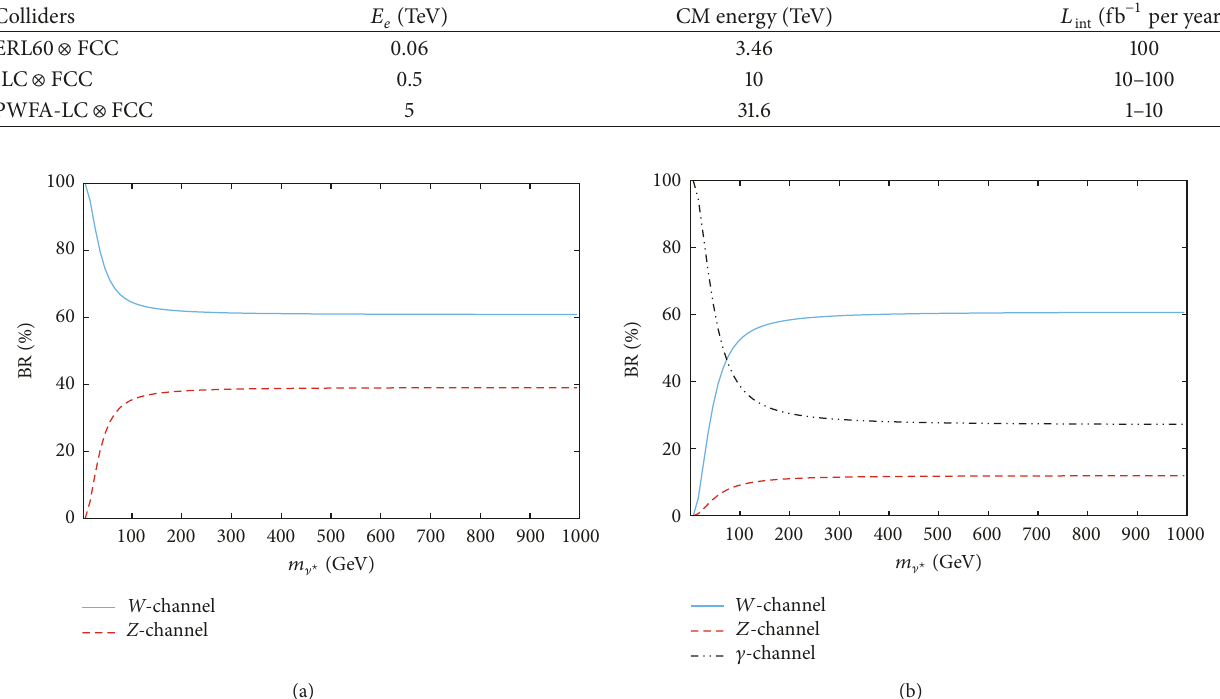
Construction of the future 𝑒 + 𝑒 − and 𝜇 + 𝜇 − colliders tangential to the FCC will also provide several 𝑒𝑝 and 𝜇𝑝 collider options